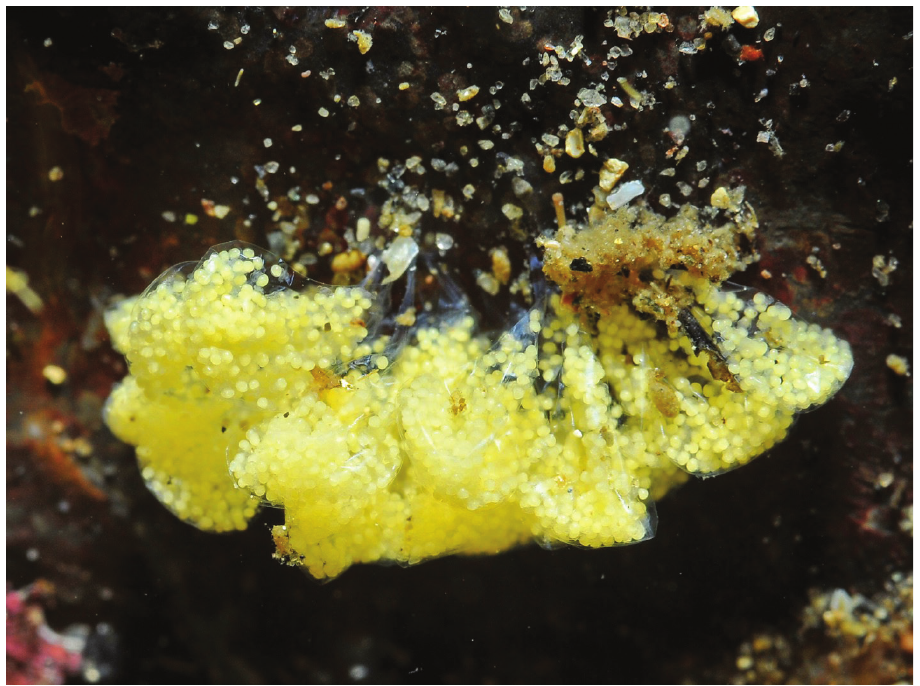
Figure 8. Egg capsules of Calyptraea aurita . Female was removed by the diver, 31 January